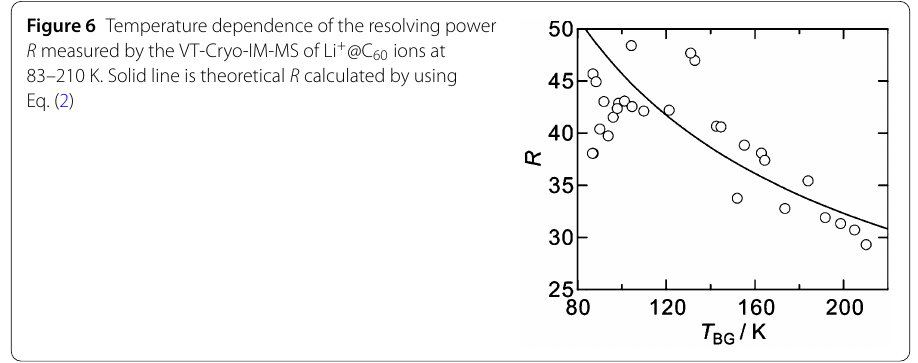
Figure 6 Temperature dependence of the resolving power R measured by the VT-Cryo-IM-MS of Li + @C 60 ions at 83–210 K. Solid line is theoretical R calculated by using Eq.